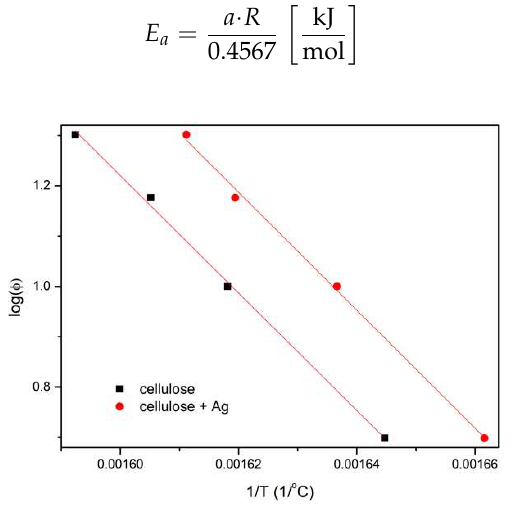
Figure 10. Plot of log( φ ) = f (1/ T m ) for the Flynn–Wall–Ozawa (FWO) method.